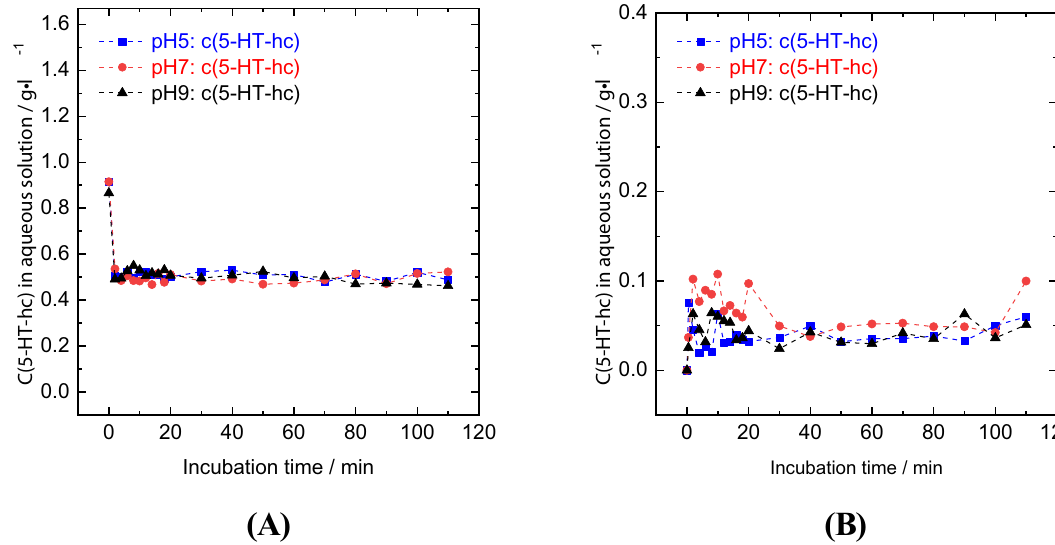
Figure 3. Uptake ( A ) and release ( B ) of 5-HT-hc by DETOXSAN at 36 °C and different pH levels.